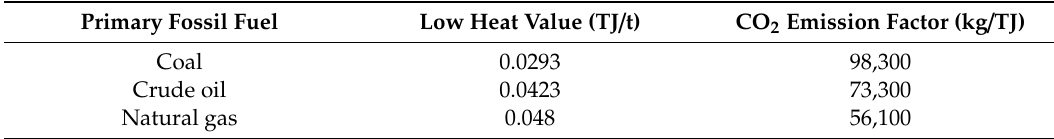
Table 1. Low heat value and CO 2 emission factor.